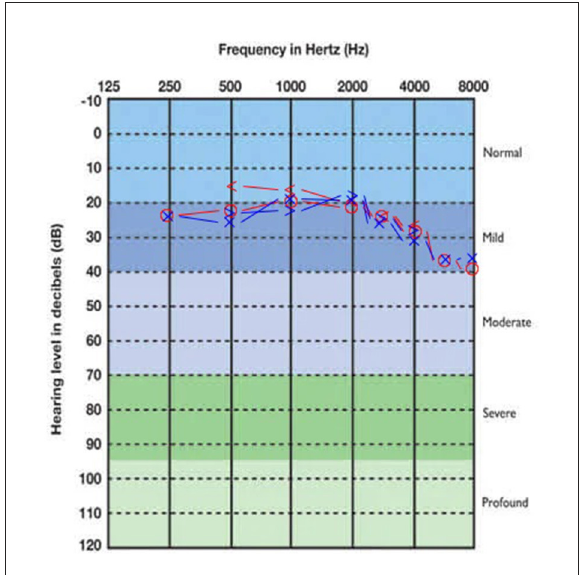
FIGURE2 Average audiogram of PCT group patients. Right ear thresholds in red, left ear in blue.